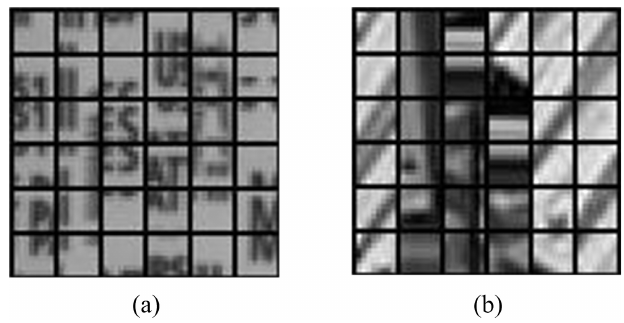
Figure 4. Stochastic Image Patches and Dominant Orientation Image Patches, (a) shows stochastic image patches, (b) shows dominant orientation image